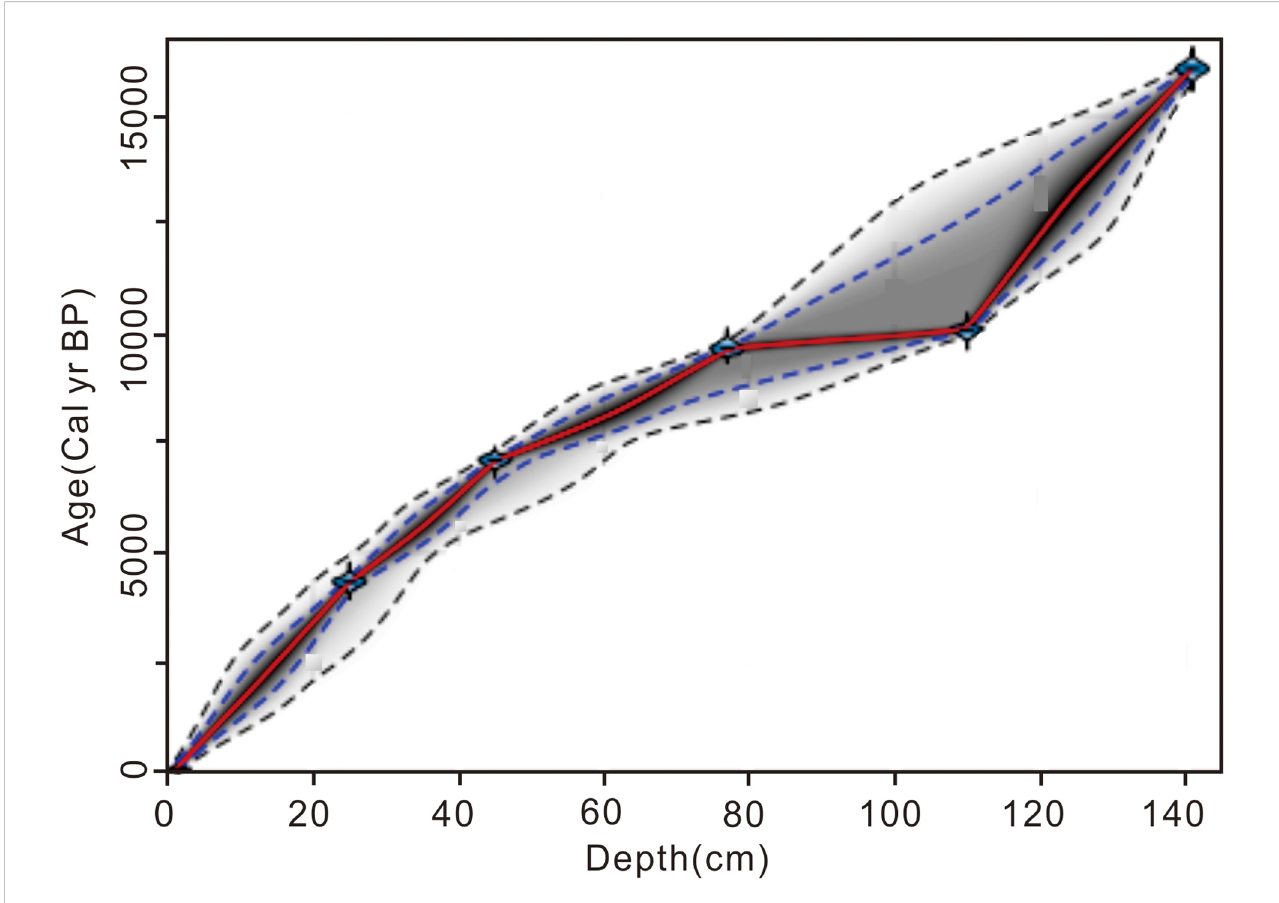
FIGURE 2 Age-depth model for core SCS18-1.